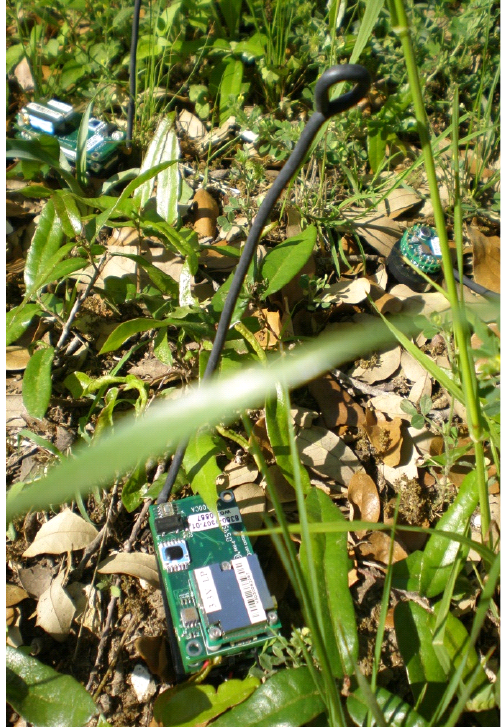
Figure 6. Implementation of reinforcement learning on sensors in an outdoor environment, by using MTS400 CA embedded board with external